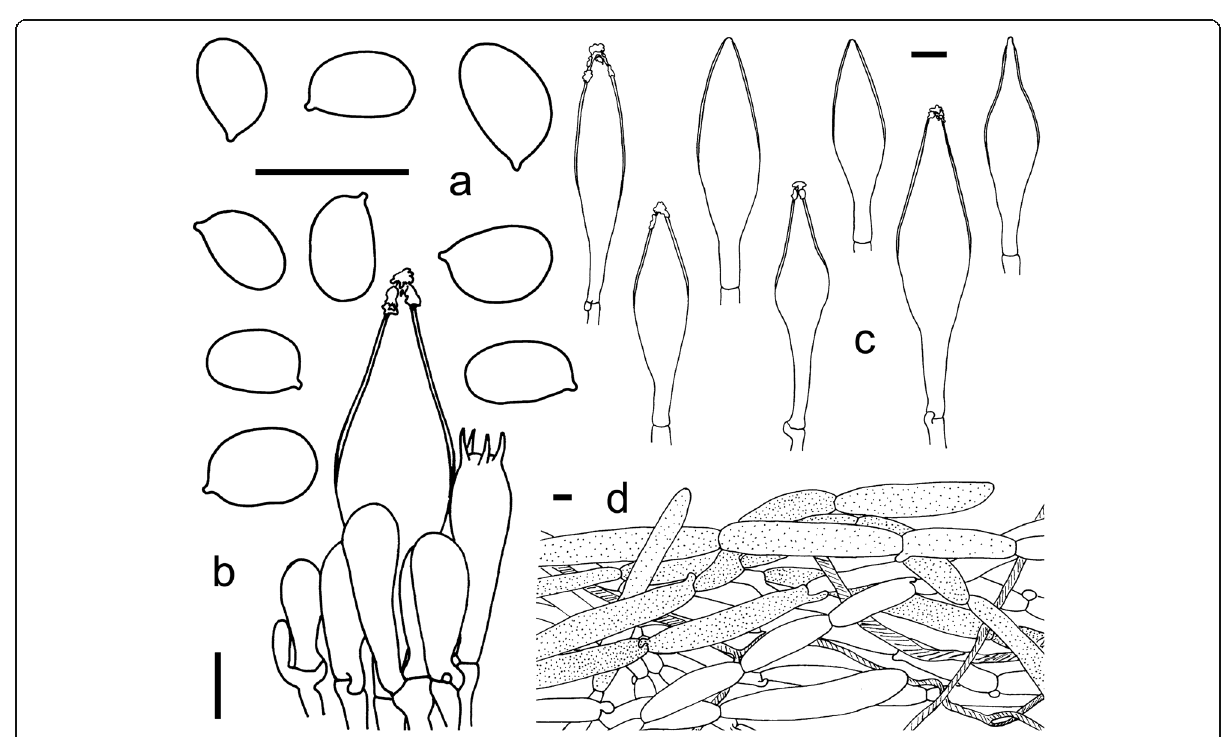
Fig. 12 Microscopic features of Squamanita sororcula (HKAS107306A, holotype). a Basidiospores. b Hymenium and subhymenium with one pleurocystidia covered with refractive incrustations. c Pleurocystidia, four of them covered with refractive incrustations. d Pileipellis section. Drawings by Jianwei Liu. Bars = 10 μ